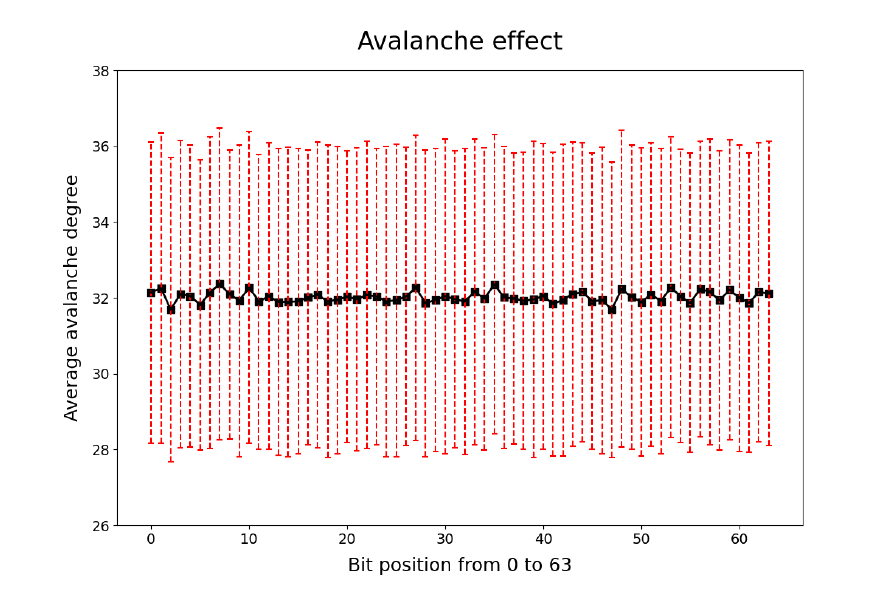
Figure 8. The average avalanche degree of SIMON64/128.